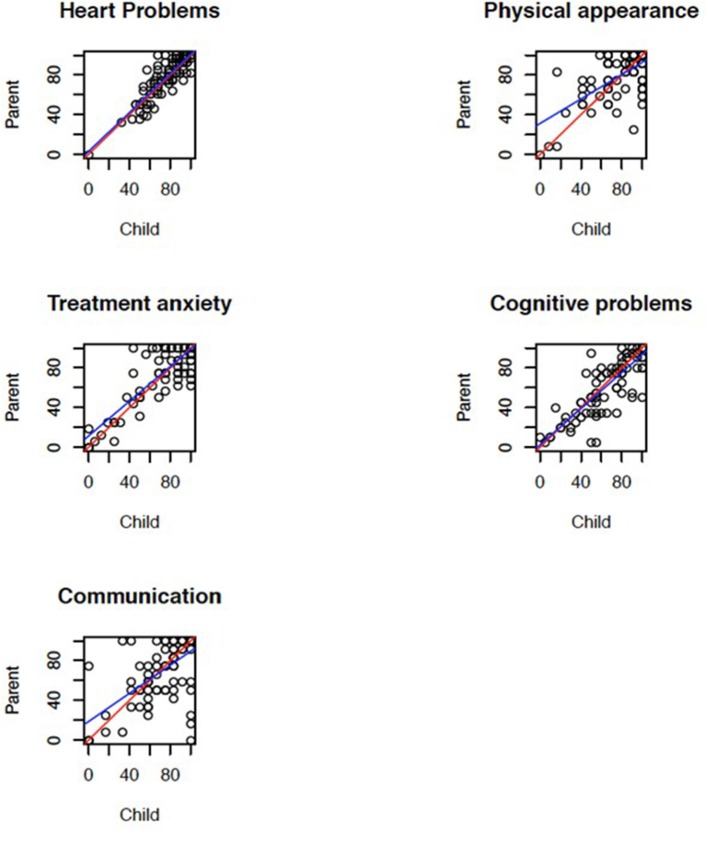
Scatterplot with each point corresponding to a child-parent pair to show the correlation between children and parents for the domains of the PedsQL cardiac module. The red line is perfect agreement and the blue line is the robust least-squares fit.